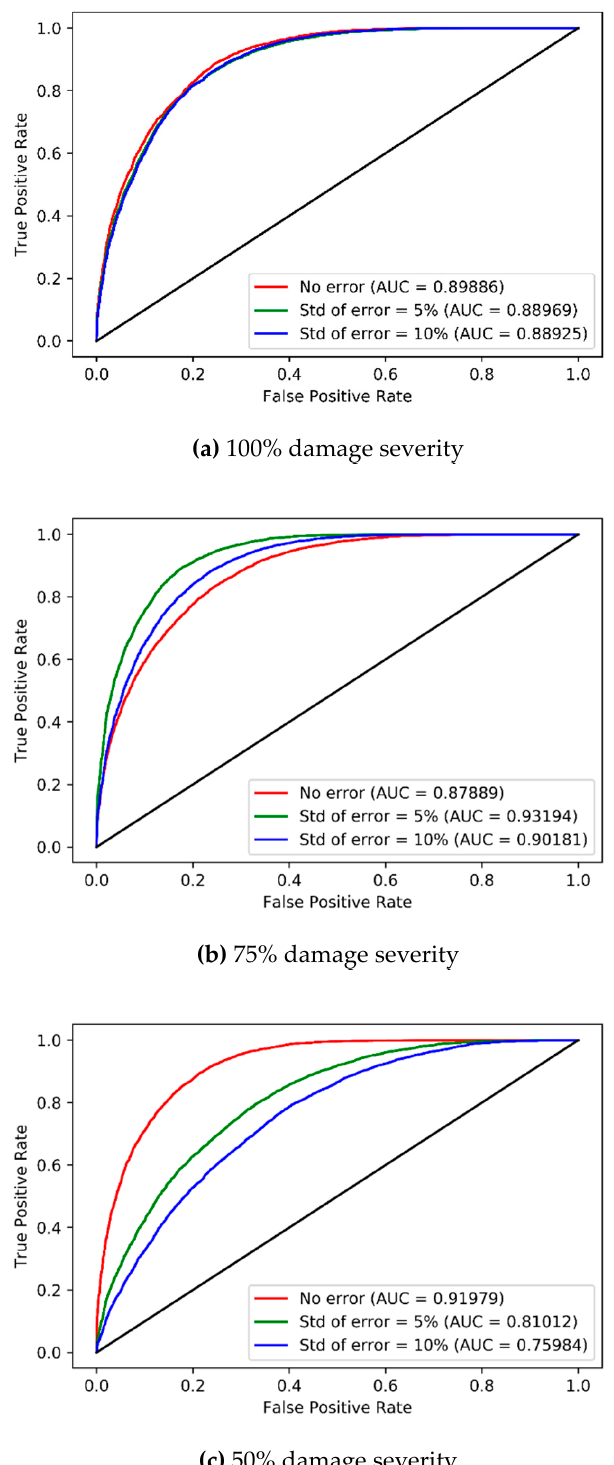
Figure 11. ROC curves and AUCs of CAE models corresponding to three levels of measurement errors for multi ‐ vehicle traffic loads.